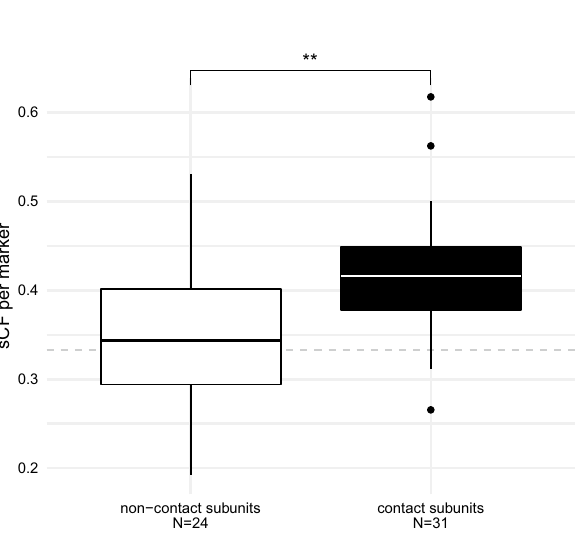
Figure 4. The phylogenetic signal in “contact” and “non-contact” nu-OXPHOS subunits. Boxplot comparing the sCF of nu-OXPHOS markers in direct contact with mitochondrial subunits and the sCF of nu-OXPHOS markers that are not in direct contact. Dashed gray line at 0.33 marks the threshold below which the branch with the highest figure of sCF between the three possible resolutions is not the one that support the mt-topology. Significance calculated through a Student’s t-test (t = − 2.862, p value = 0.006363, d.f. = 23,